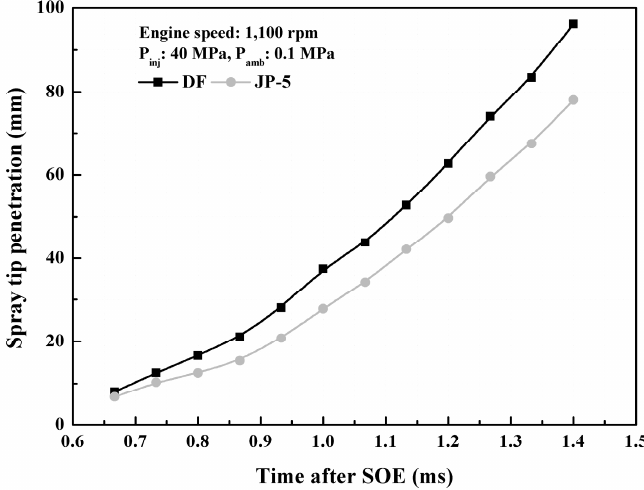
Figure 3. Spray tip penetration of the DF and JP-5 fuel.